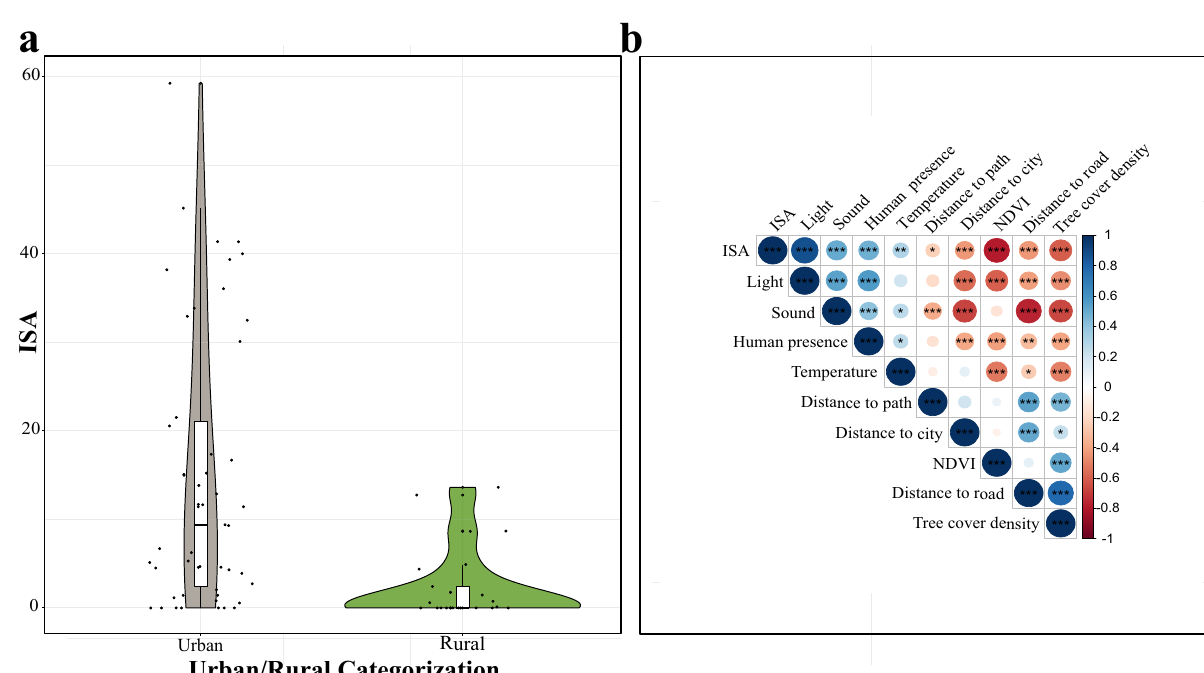
Figure 3. ( a ) Violin plots with embedded box plots comparing the distribution of ISA percentages in urban and rural sites. The line within the box plots indicates the median and the lower and upper boundary of the boxes indicates the 25th and 75th percentile, respectively. Whiskers above and below the boxes correspond to 1.5 times the inter-quartile range (IQR) above and below the 25th and 75th percentile, respectively. ( b ) Correlation between ISA and environmental variables. The significance was determined based on Pearson’s correlation tests, at p -values ≤ 0.05 (*), p ≤ 0.01 (**), and p ≤ 0.001 (***). The sizes of the circles are proportional to Pearson’s correlation coefficients. The figure was generated in R version 4.0.0 68